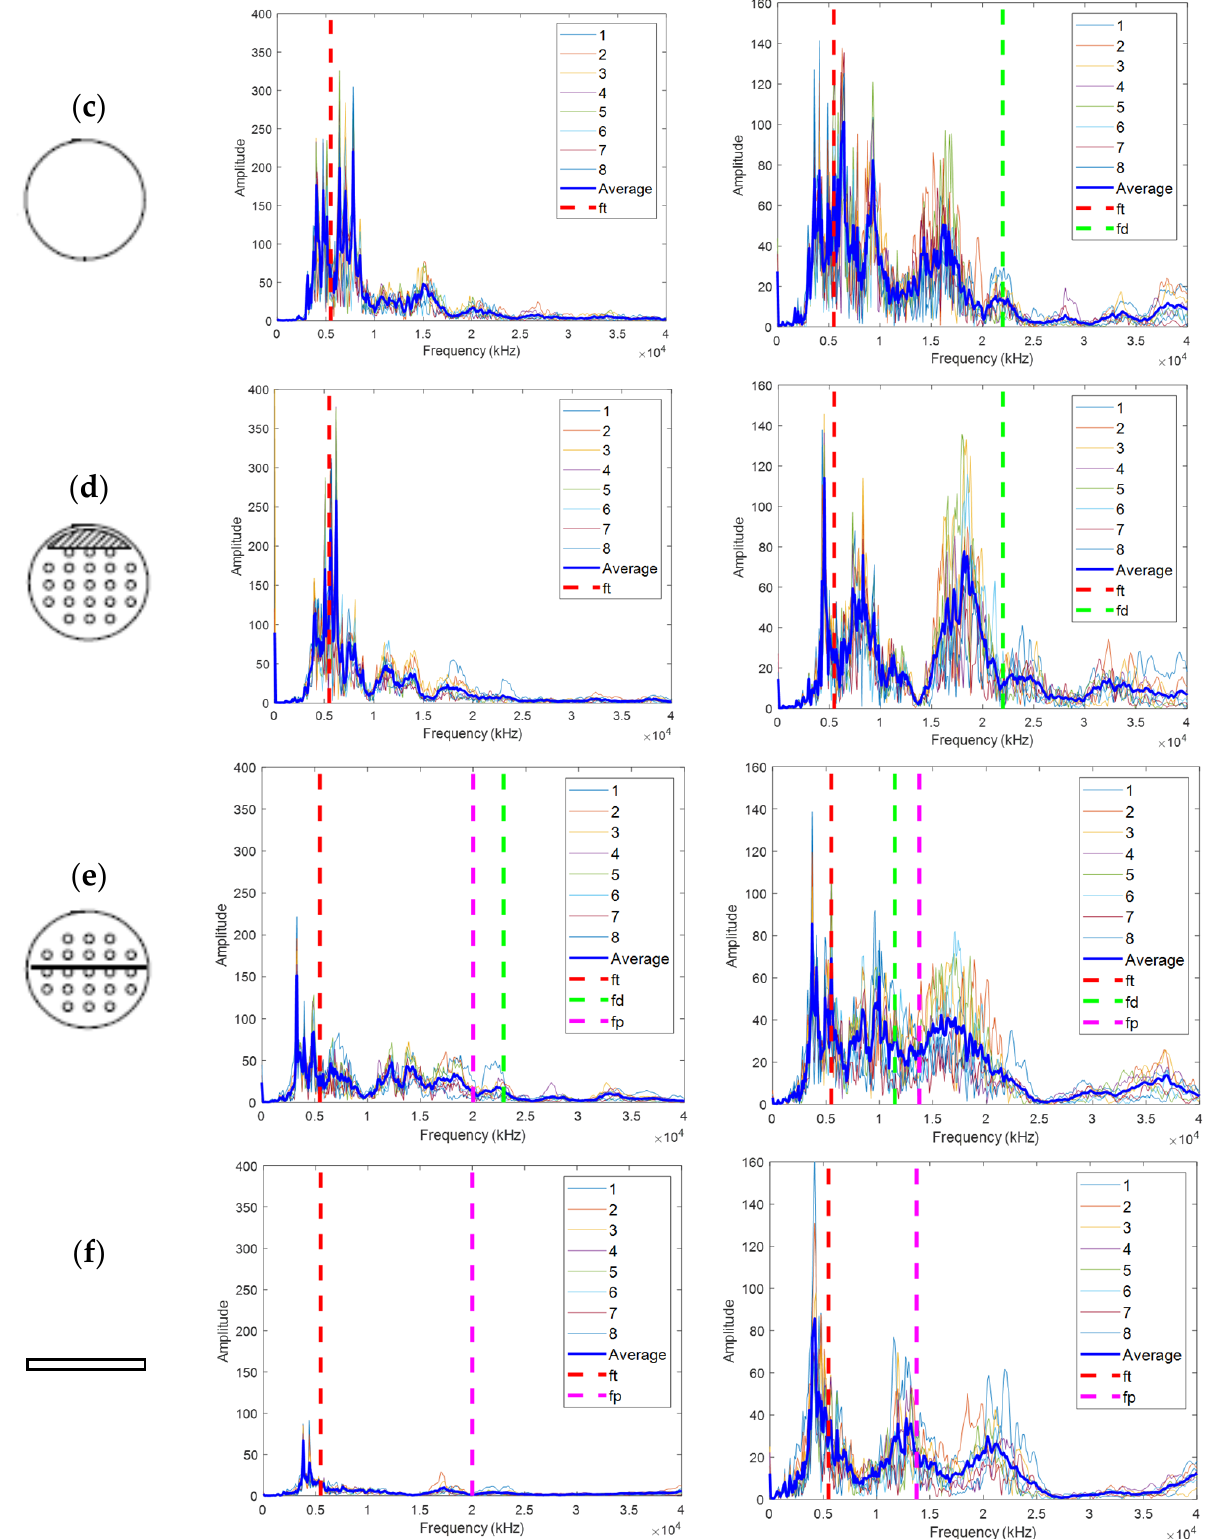
Figure 13. Spectrum results by type for depths of 50 mm (d50) and 100 mm (d100) by IE test. ( a ) N400. Slabs: ( b ) A; ( c ) B; ( d ) C; ( e ) D; ( f ) E.